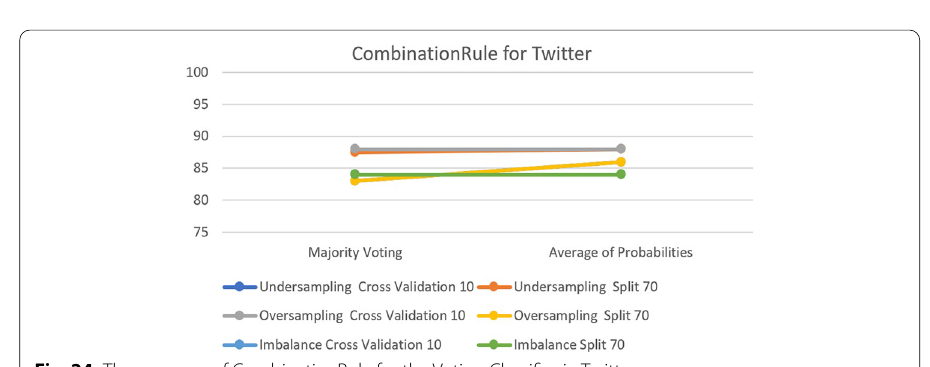
Fig. 24 The accuracy of CombinationRule for the Voting Classifier in Twitter